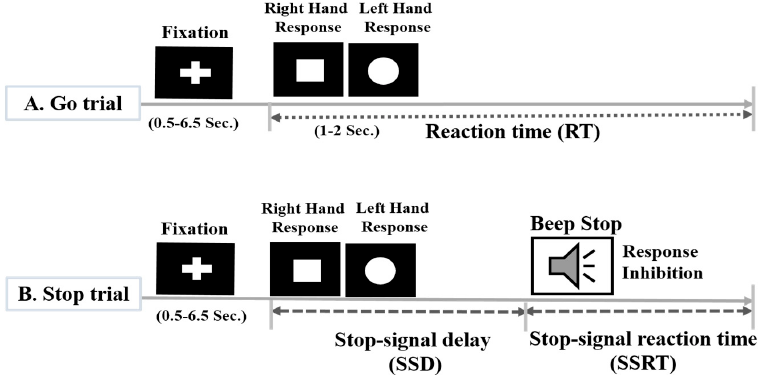
Figure 1. Design of the stop-signal task to investigate the neural activities of human response inhibition. In go trial: a square required a left-hand response (LHR) and a circle required a right-hand response (RHR). In stop trial: a beep sound was used as a stop signal to instruct the participants to withhold their LHR or RHR.